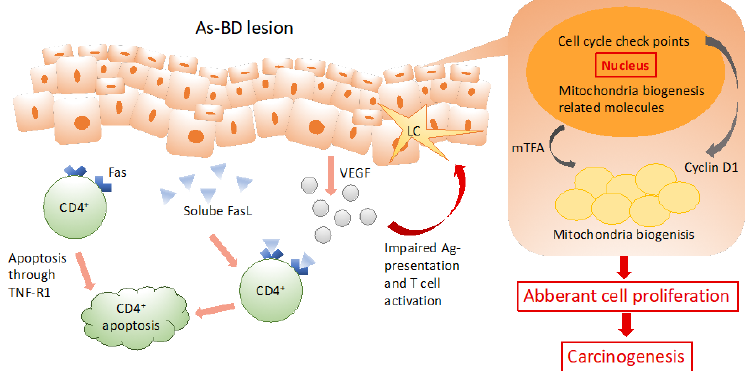
Figure 1. Aberrant immune activation of Langerhans cells (LCs) and CD4 + cells provides a reliable illustration for the impairment of anti-tumor surveillance in As-BD. In As-BD lesions, keratinocytes (KC) are the significant target. Dysregulated energy homeostasis and aberrant cell proliferation present as crucial role in arsenic-induced